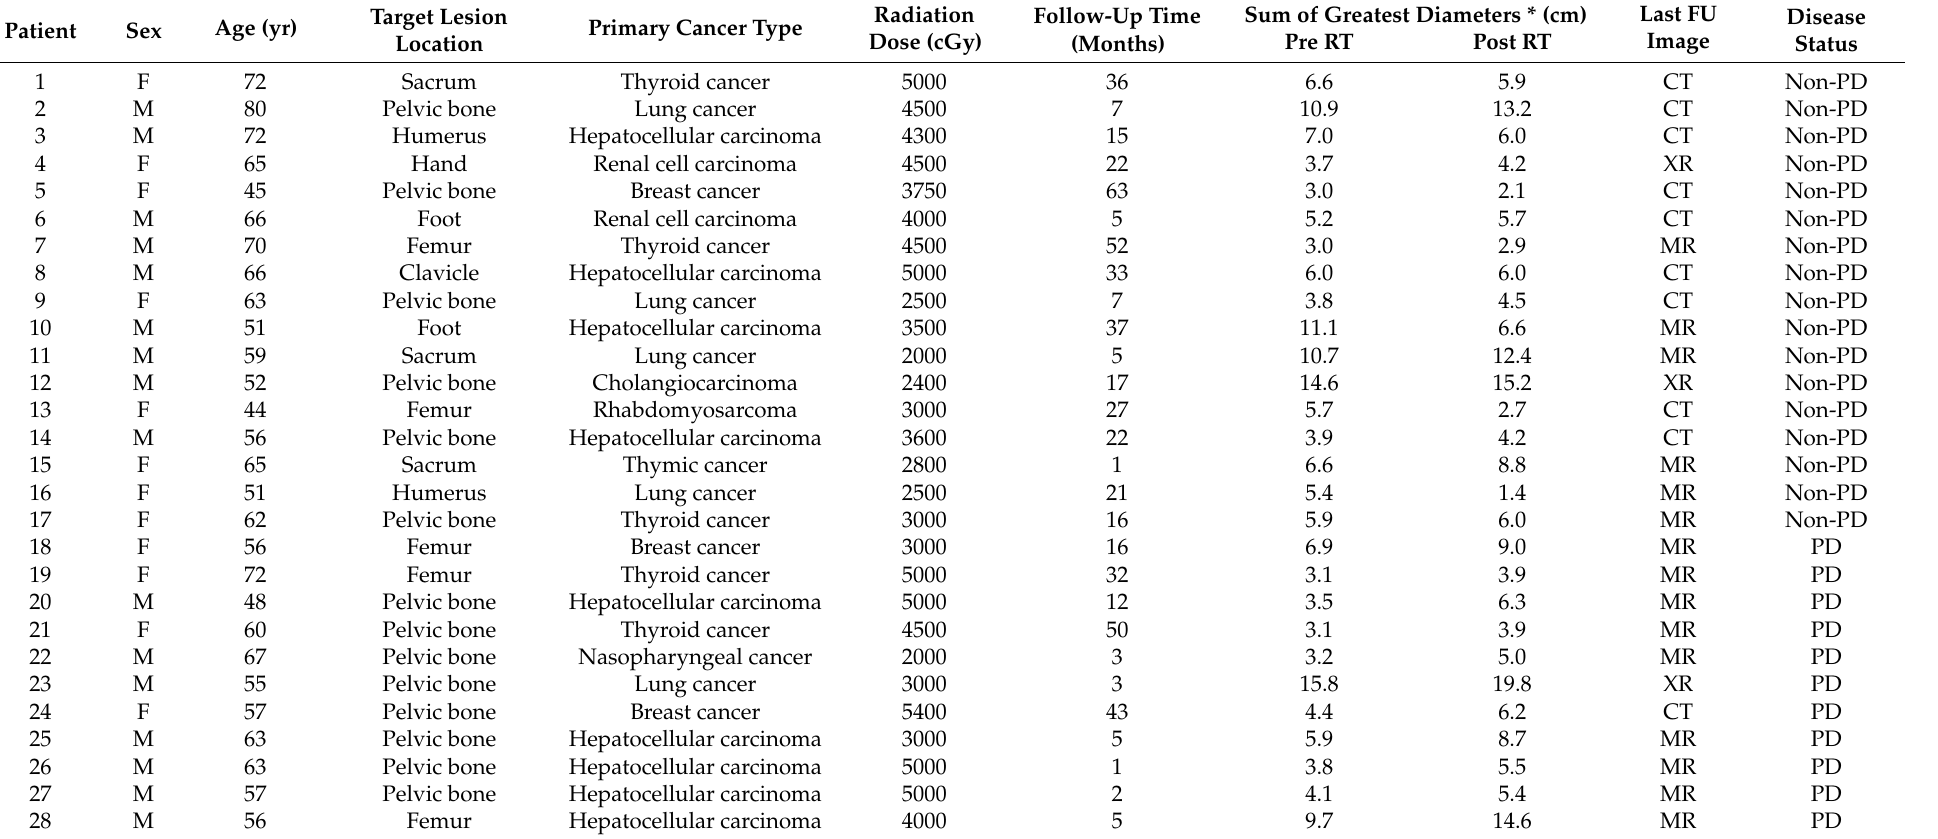
Table 1. Patients’